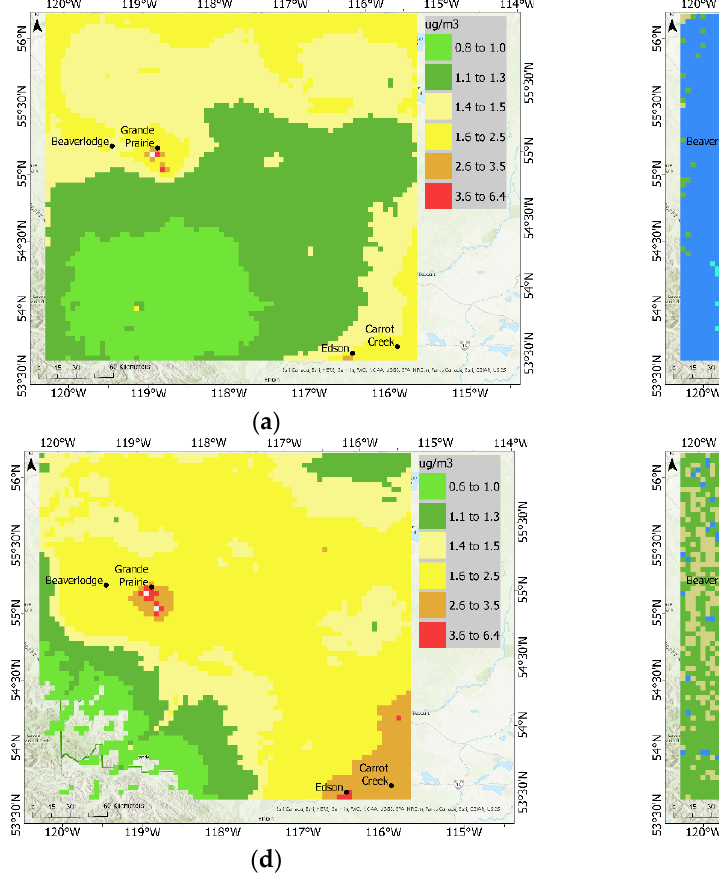
Figure 7. ( a ) Predicted average hourly PM 2 . 5 concentrations for ( a ) CB6R3 (summer), ( b ) CB6R3 vs. SAPRC07 1 (summer), ( c ) CB6R3 vs. RACM2 2 (summer), ( d ) CB6R3 (winter), ( e ) CB6R3 vs. SAPRC07 1 (winter), ( f ) CB6R3 vs. RACM2 2 (winter). 1 [100*(SAPRC07 − CB6R3/CB6R3)] 2 [100*(RACM2 − CB6R3/CB6R3)].